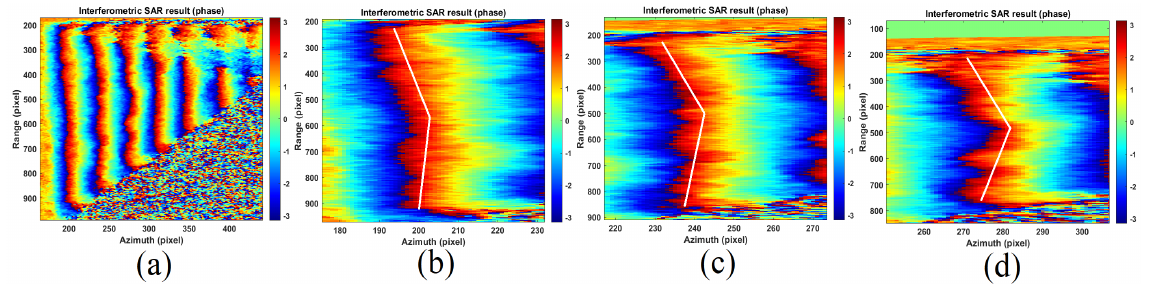
Figure 16. Representation in particular of the pyramid of Kefren. Interferometric phases. ( a ): west side. ( b – d ): magnification of interferometric fringe 1, 2, and 3.